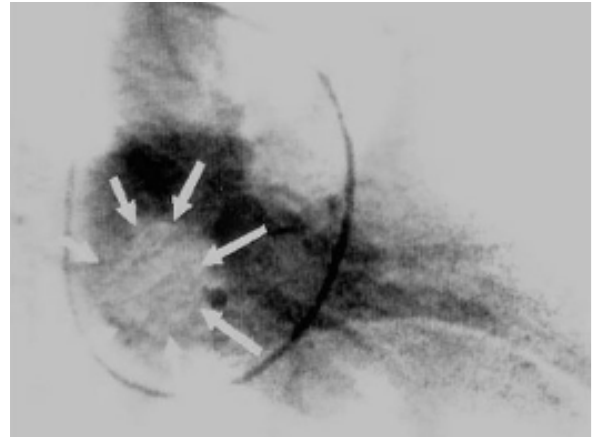
Fig. 1 – Estudo hemodinâmico evidenciando o Hemangioma Fig. 2a - Hemangioma - Aspecto